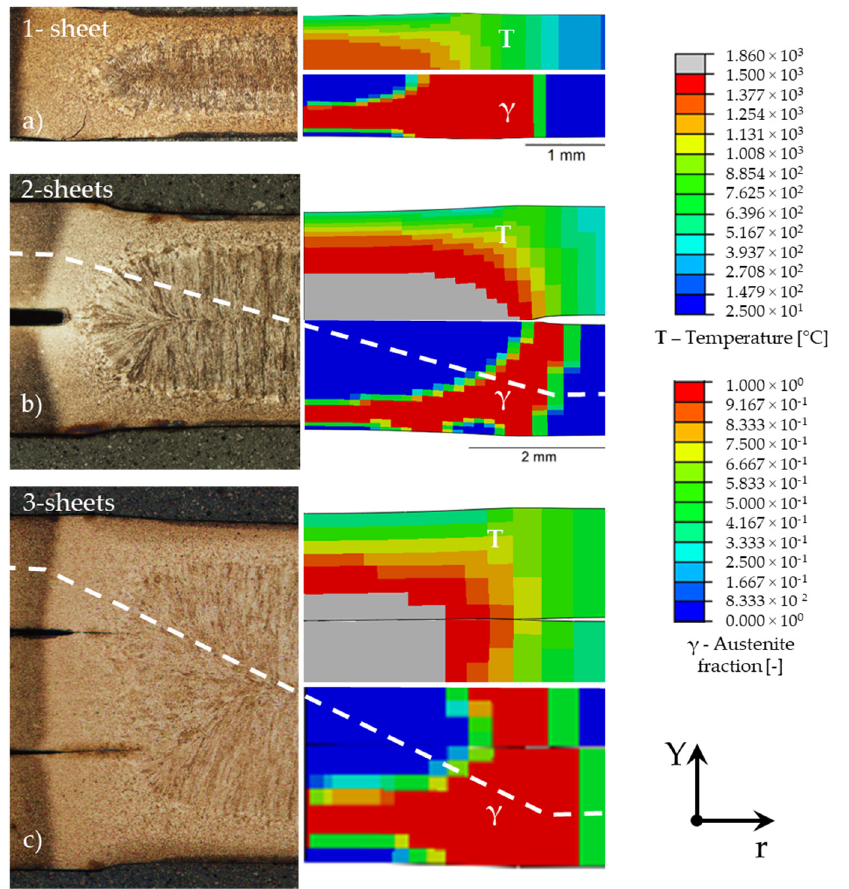
Figure 6. Micrographs (left column) and simulation results (right column) of ( a ) 1-, ( b ) 2- and ( c ) 3-sheet stack ups for I = 6.6 kA, F = 4.5 kN, welding time t w = 380 ms, holding time t h = 300 ms (configuration 23 in Table 2).